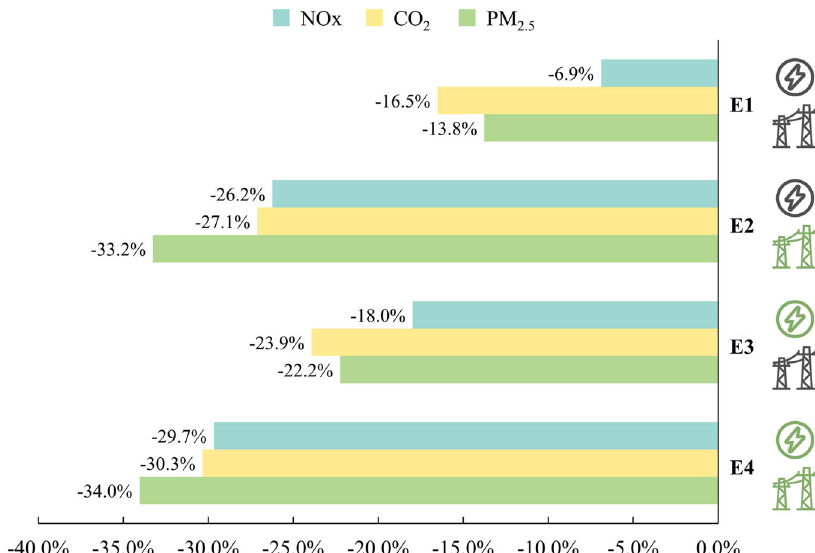
Fig. 5 Reduction ratios of NOx, CO 2 , and PM 2.5 emissions under different electri fi cation scenarios relative to Scenario S3. Scenario E1 further considers vehicle electri fi cation based on Scenario S3, and EV energy ef fi ciency and emission levels from electricity generation are both at the current level. Scenarios E2 and E3 build on Scenario E1 by considering a cleaner generation mix in the electric power structure and advances in EV energy ef fi ciency, respectively. Scenario E4 takes into account three technical innovations: vehicle electri fi cation, EV energy consumption, and electric power structure. Grey icons represent current levels, and green icons represent future